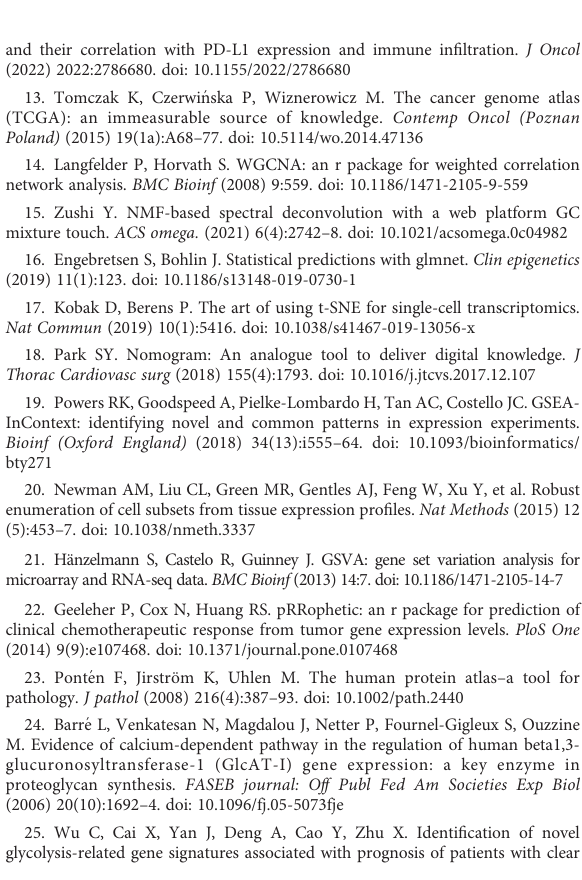
SUPPLEMENTARY FIGURE 1 (A) The heatmap of glycosylation-related DEGs. (B) Clustering dendrograms and trait heatmap of HCC and adjacent tissues. (C) The glycosylation-related DEGs clustering based on TOM dissimilarity. (D) All heatmaps obtained by NMF consensus clustering. SUPPLEMENTARY FIGURE 2 Correlation between clinicopathological features and risk score or risk groups. Expressionof clinicopathological featuresin riskscore: (A) Age (B) Gender. (C) Grade. (D) M stage. (E) Stage. (F) T stage. Association between clinicopathological features and low- and high-risk groups by K-M survival analysis: (G) Grade 3-4. (H) M1 stage. (I) N0 stage. (J) Nx stage. (K) Stage III-IV. (L) T3-T4 stage. SUPPLEMENTARY FIGURE 3 Analysis the proportion of immune in fi ltration cells and functional enrichment. (A) The proportion of immune in fi ltration cell in low- and high-risk groups. (B) The biological functions, cellular component, and molecular function between low- and high-risk groups. (C) The mainly signaling pathway by KEGG